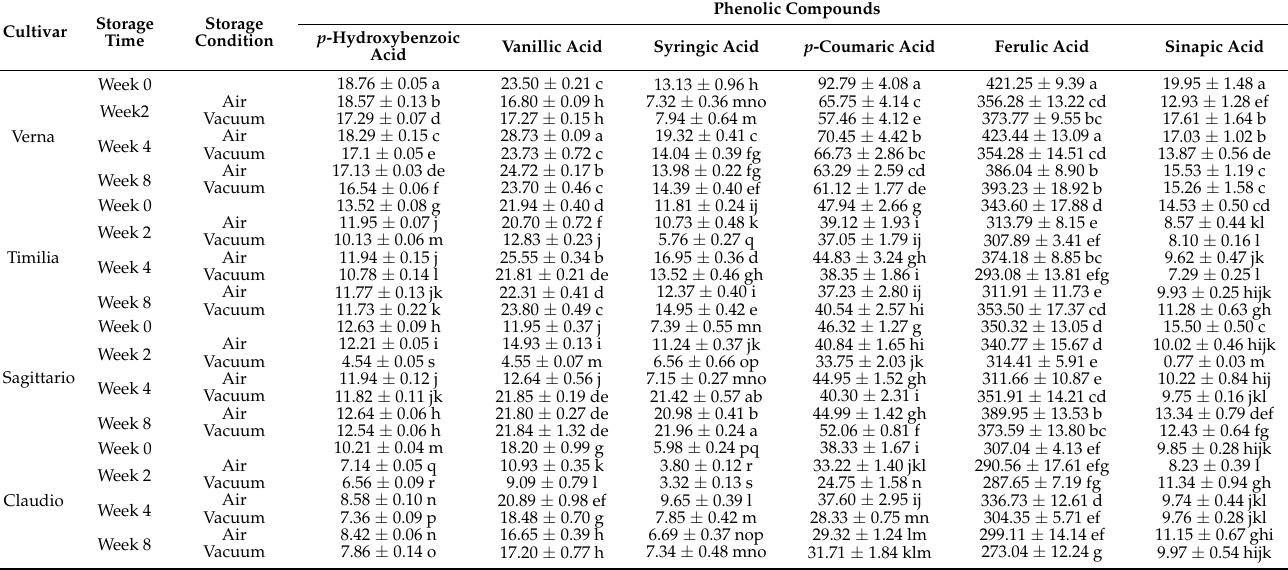
Table 4. Phenolic acid profiles of four wheat varieties cultivars ( µ g/g) stored under different conditions and for different lengths of